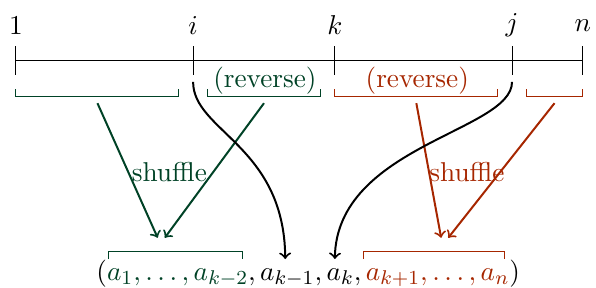
Figure 3 . The shu(cid:15)es appearing in the s ij -form on the right-hand side of (4.6) for a (cid:12)xed i < k (cid:20) j . The values i and j are not included in the indicated ranges. The middle two intervals are reversed to descending order before the shu(cid:15)es. The origin of this reversal is (E.14). All sequences